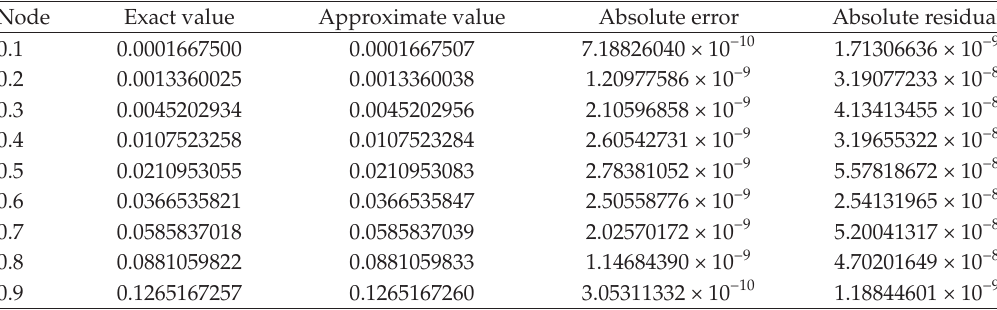
Table 6: Numerical results for Problem